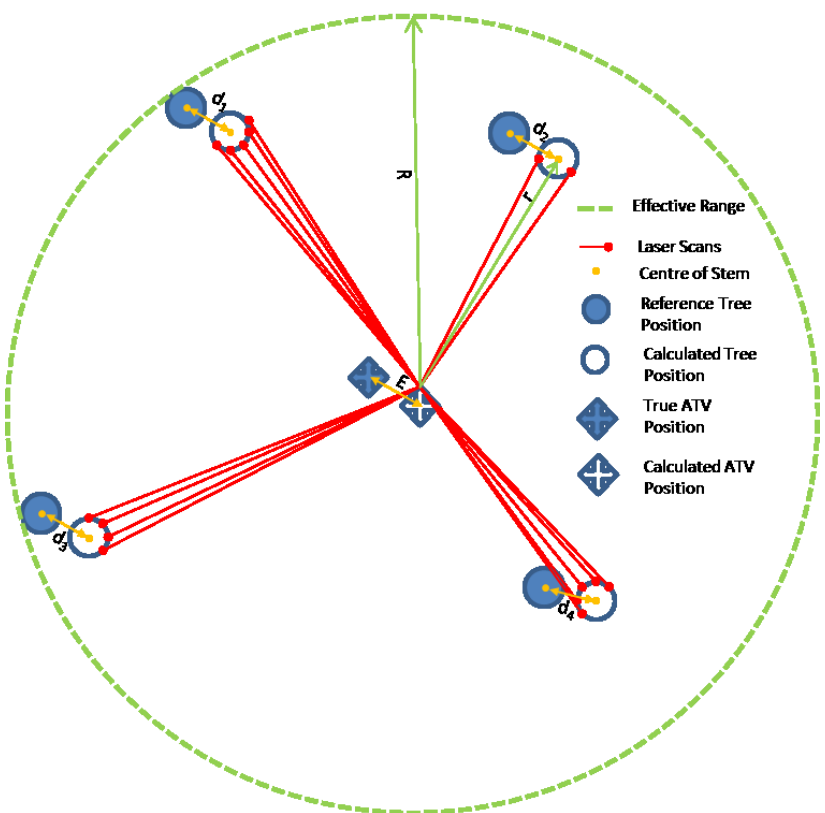
Figure 6. Tree Reference network for evaluating the positioning accuracy of the ATV trajectory.